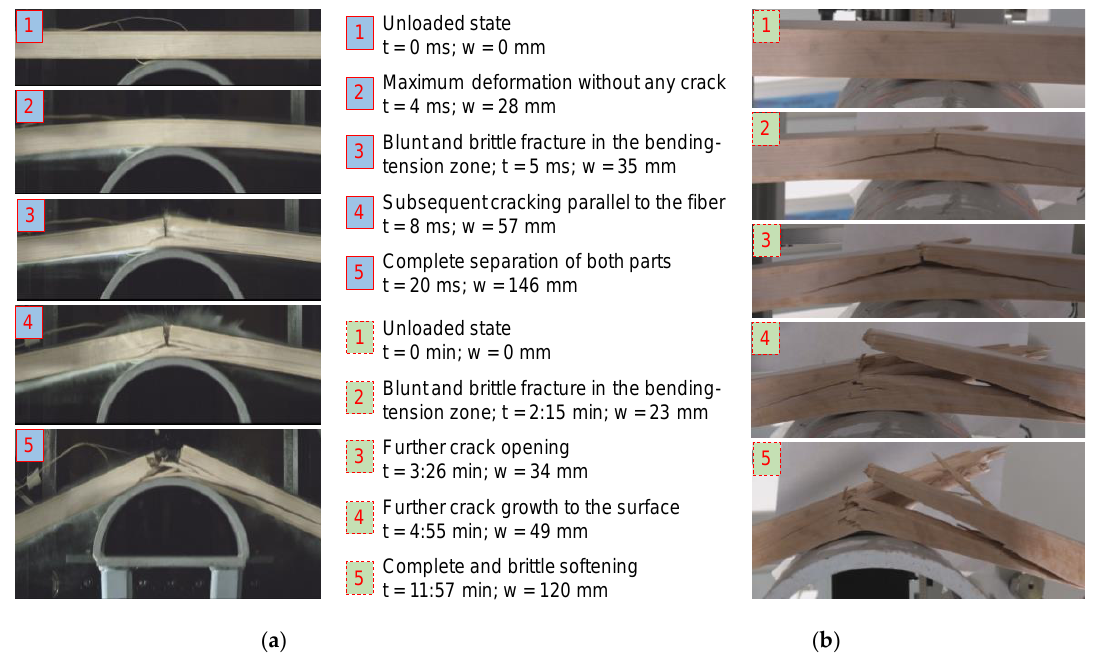
Figure 11. Exemplary loading and failure sequence in a dynamic ( a ) and a quasi-static sample ( b ) in series −30 °C.